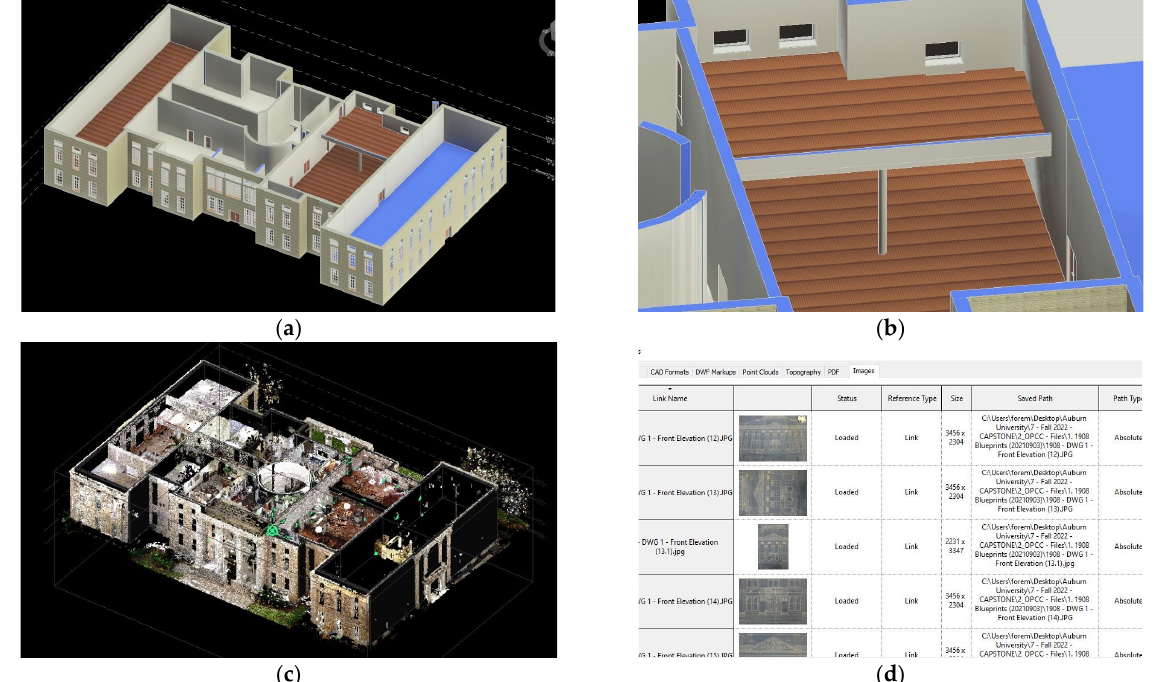
Figure 27. Demonstration of the HBIM “General Model” supplement to LOD 200: ( a ) 3D model detail of main building elements in Revit; ( b ) main building elements of the 1908 courtoom were created; ( c ) model imposed with TLS point cloud; ( d ) a view showing incorporation of the 1908 blueprints as general conservation documentation to the model in Revit.